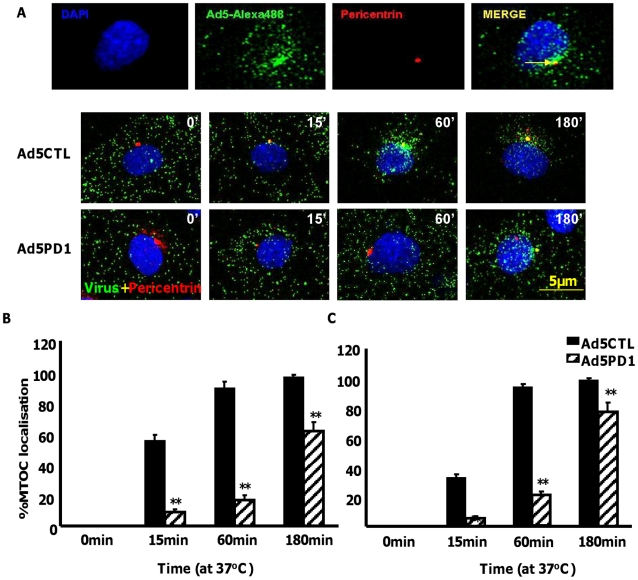
Delayed FX-mediated transport of αv integrin binding-defective Ad5 in vitro.10,000 vp/cell of Alexa488-labelled Ad5CTL or Ad5PD1 (green particles) in the presence of FX were allowed to bind cells for 1 h at 4°C, then incubated at 37°C for increasing lengths of time (15 min, 60 min, 180 min) to allow internalisation and transport prior to fixation and staining for the MTOC marker pericentrin (A). Specific binding of a primary antibody against pericentrin (A, upper panel) was detected using an Alexa546-labelled secondary antibody (red). Nuclei were counterstained using DAPI. Images were captured on a confocal microscope under a 63× objective. (B+C) Percentage of cells with colocalisation of fluorescently-labelled Ad5CTL or Ad5PD1 with the MTOC marker pericentrin in SKOV3 (B) or A549 cells (C) was calculated by analysing at least 5 separate 40× microscope fields per experimental condition. ** = p<0.01 compared to Ad5CTL values, error bars represent S.E.M.